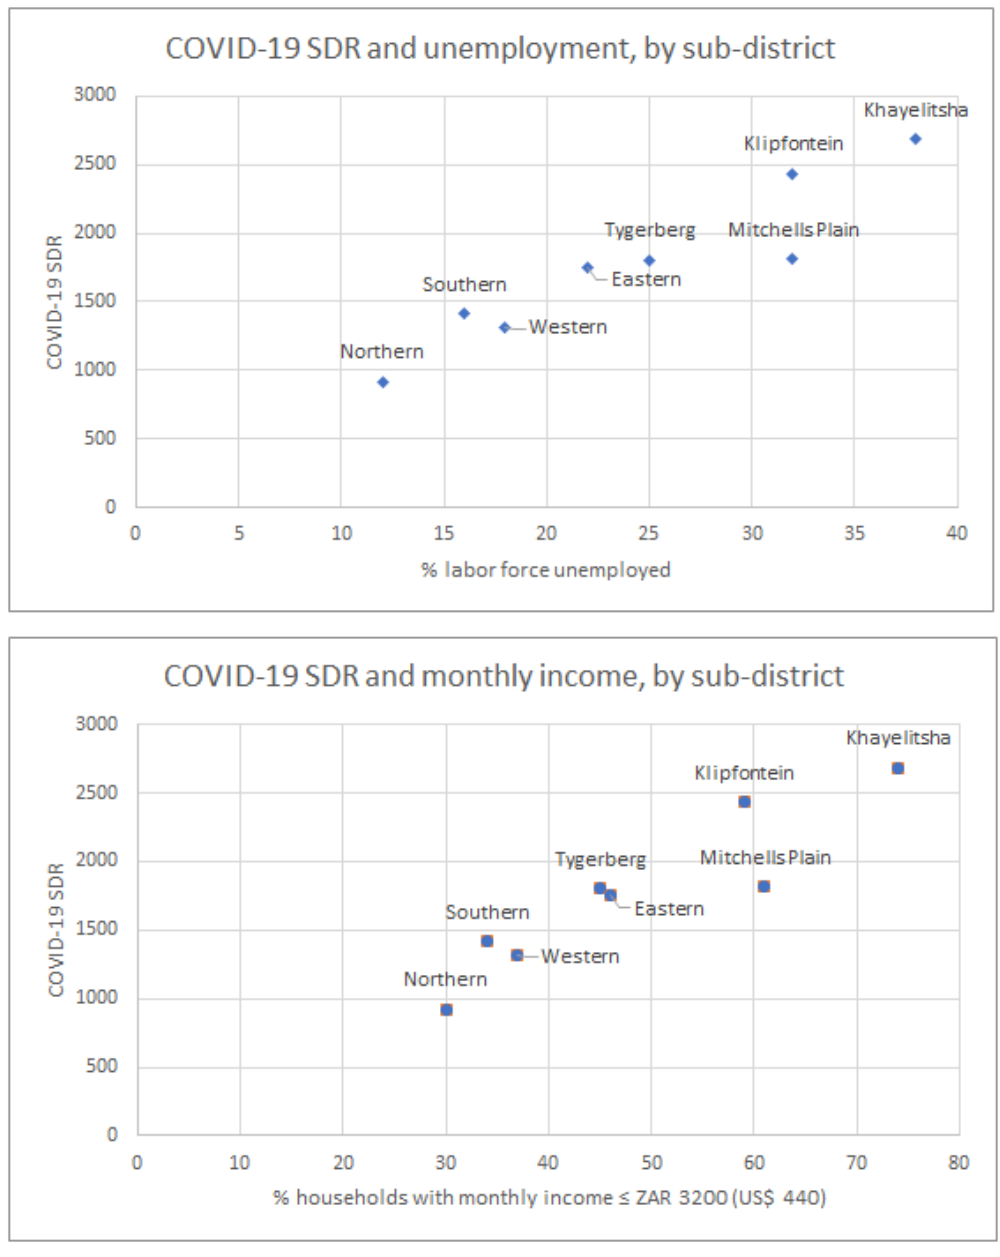
Figure 3a and 3b. Total COVID-19 Standardized Death Rate (SDR) and percent of labor force unemployed ( a ) and household monthly income ( b ), taken from the 2011 Census 3 , and plotted for each Cape Town Metro sub-district.